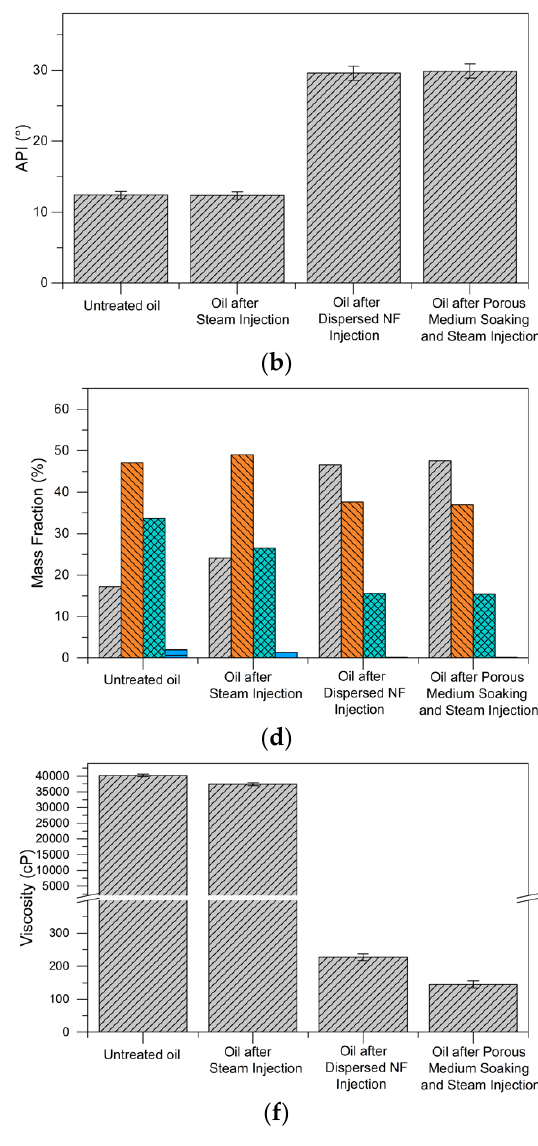
Figure 2. ( a , b ) API gravity and ( c , d ) SARA content distribution in wt.% (gray is saturates, orange is aromatics, green is resins and blue is aromatics) and ( e , f ) crude oil viscosity for untreated extra-heavy oil and crude oil recovered after the steam injection, during the injection of Al-NF dispersed in a steam stream, and after soaking for ( a , c , e ) HO1 and ( b , d , f ) HO2. The presence of the NF generates a decrease from 1.76% to 0.7% and 0.2% of the asphaltene content in the HO1 for the respective stage after steam injection with nanofluid dispersed in its stream and subsequent steam injection after the 12 h soaking of the nanofluid with the porous medium, demonstrating the high catalytic activity of the catalyst. In the case of the HO2, the asphaltene content was reduced from 2.01% to 0.3% and 0.1% in a mass fraction in the same stages. Both crude oils had a very low final asphaltene content. However, the saturates and resins distribution change to a greater extent between both samples. In the HO1, saturates increased from 19% (stage 1) to 26% (stage 3) in